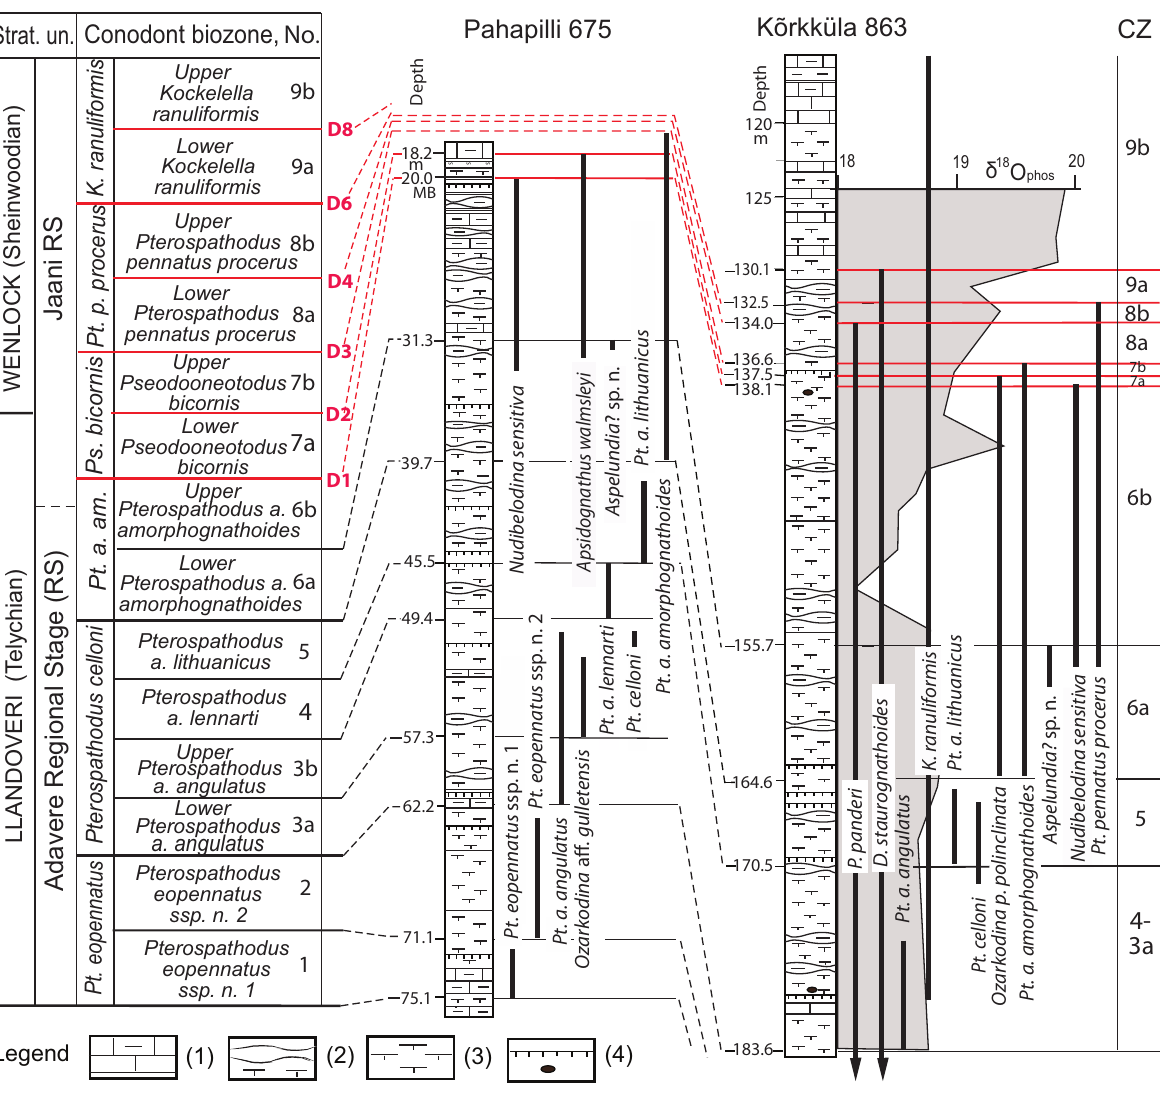
Fig. 2 . Stratigraphical scheme, conodont biozonation (with numbers referred to in the text) of the late Llandovery and early Wenlock, as well as correlation of the Pahapilli 675 and Kõrkküla 863 sections with diagnostic species of the conodont biozones. D1–D8: Datum planes of the Ireviken Event marking step by step extinctions among conodonts. The contact of the grey-white area on the right-hand side of the Kõrkküla log marks the trend in general climate change by changes in δ 18 O phos values (from 18 to 20‰) (Trotter et al. 2016). Legend for the general lithology in Figs 2–8: (1) – argillaceous limestone (upper) and limestone (lower), (2) –